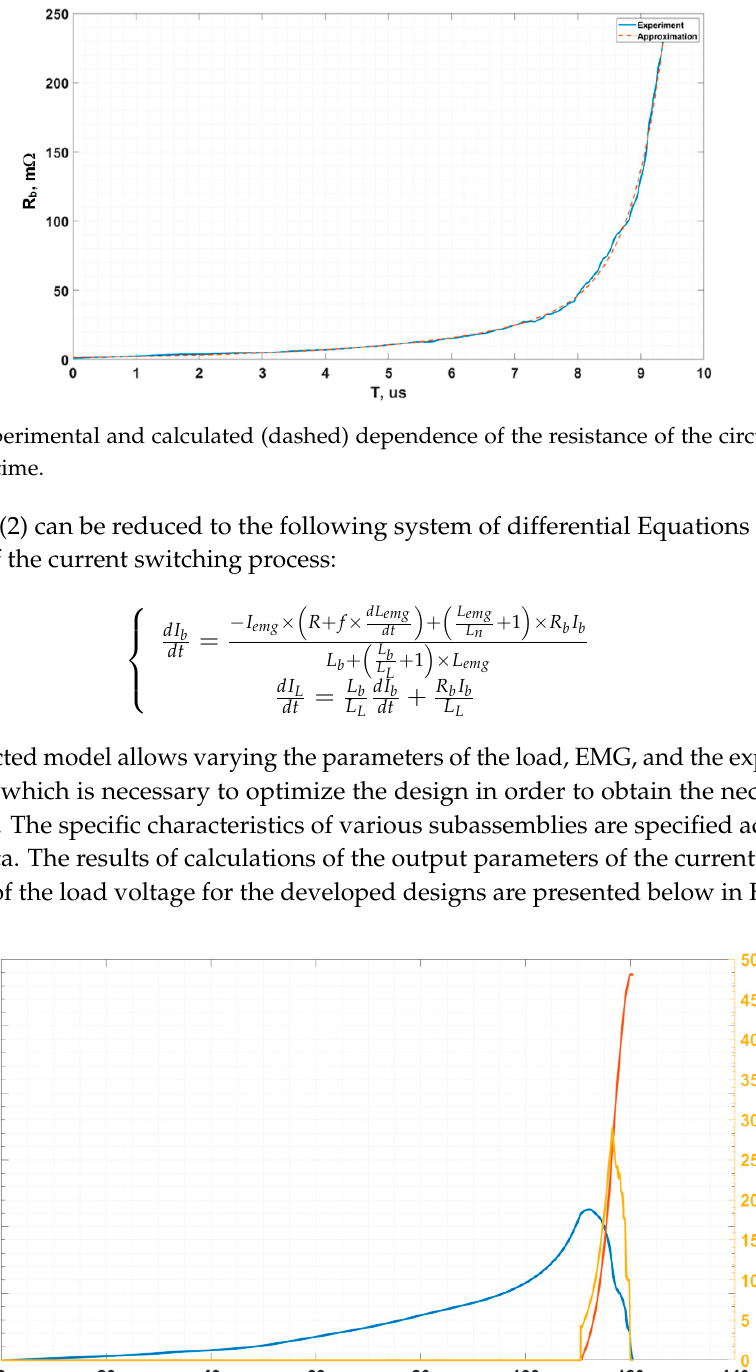
Figure 5. Calculated pulses of current in the load and load voltage during operation of the EMG. Blue— I b , current EMG; red— I L , load current; and yellow— U L , voltage on the load.